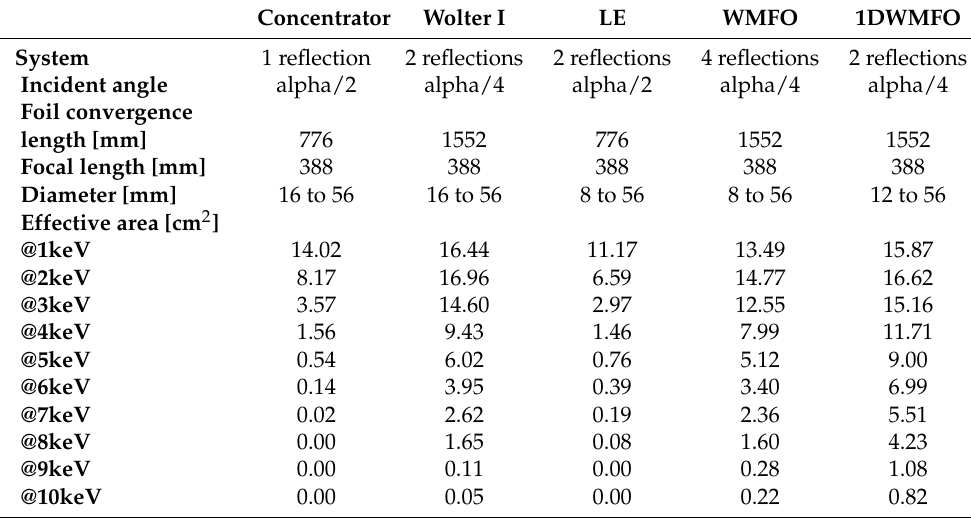
Figure 8. Various X-ray spectrometer optical concepts. Black part of aperture cannot be used for focusing. Inner circle or cross is caused by small incident angle requiring extremely long optics close to optical axis. For LE, 8 mm inner region creates ack cross of area reducing aperture area. Table 3. X-ray spectrometer optic concepts trade-off; maximum theoretical effective area versus energy calculation. Aperture area is 23 cm 2 ; focal length 388 mm. Real effective areas will be at least by one third smaller. Reduction is caused by mechanical mounting design and by related shell edges at aperture